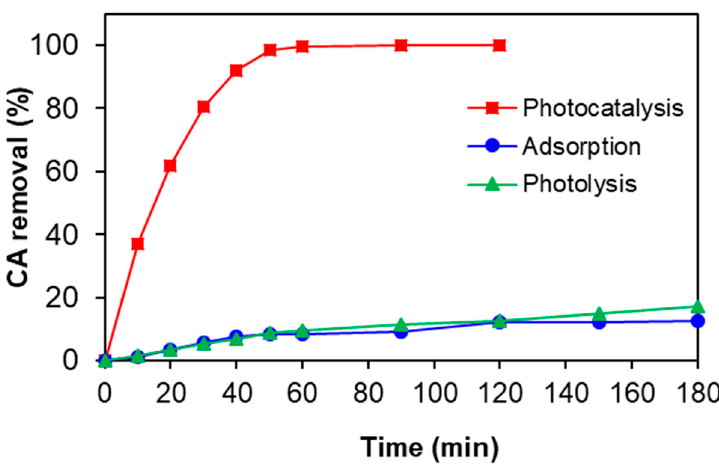
Figure 10. Comparison of the CA elimination using Zn4La400 during adsorption, photolysis and photocatalysis (500 mg/L Zn4La400, initial pollutant 3 mg/L, stirring rate of 450 rpm and UV-A irradiation).